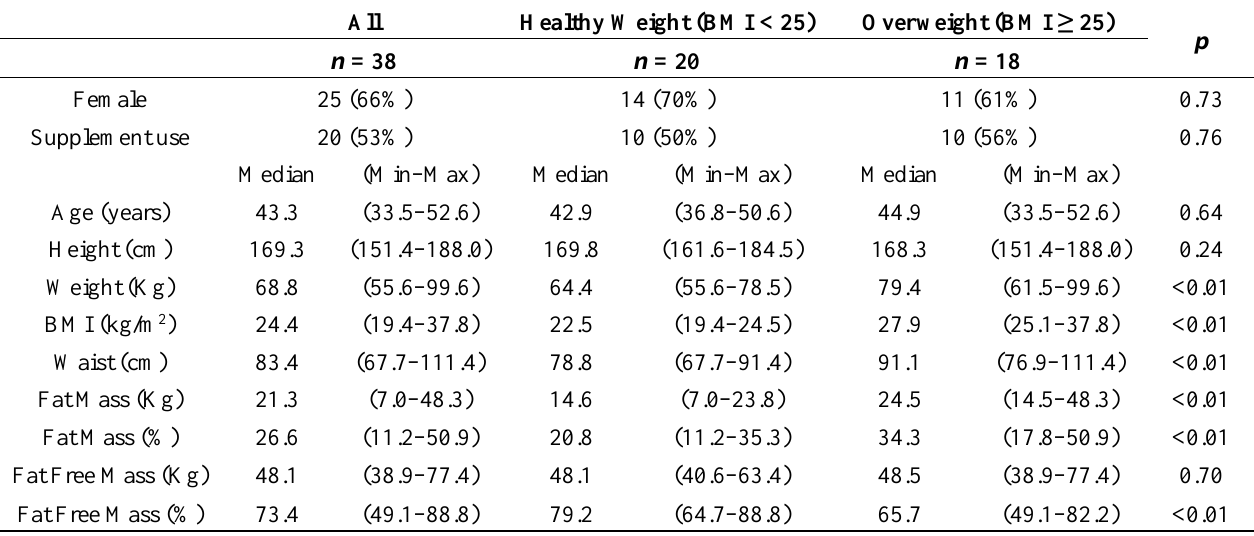
Table 1. Anthropometric summary for n = 38 participants from 26 families, by weight category.